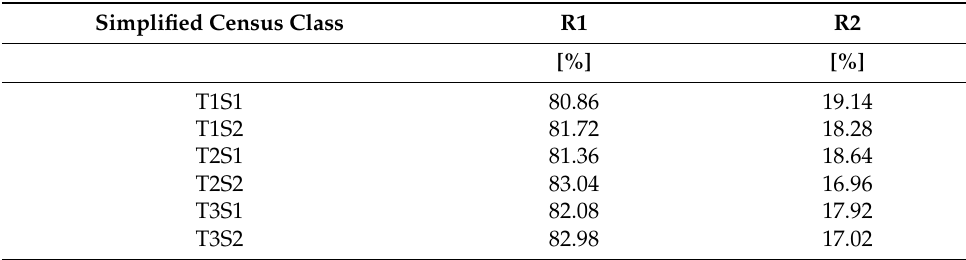
Table 7. Simplified census classes TxSy, related to construction timespan (T) and number of stories (S), percentage disaggregation according to state of repair (R).